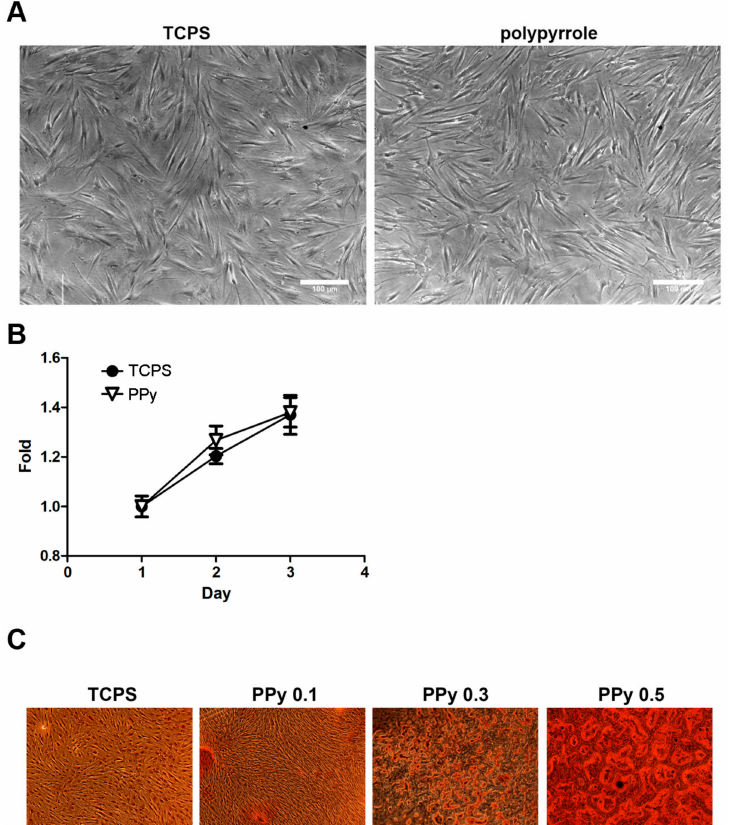
Figure 2. ( A ) Phase contrast images of human dental pulp stem cells (hDPSCs) on TCPS (left) and PPy films (right). The hDPSCs were cultivated on TCPS or PPy for 3 days. The cells on both materials